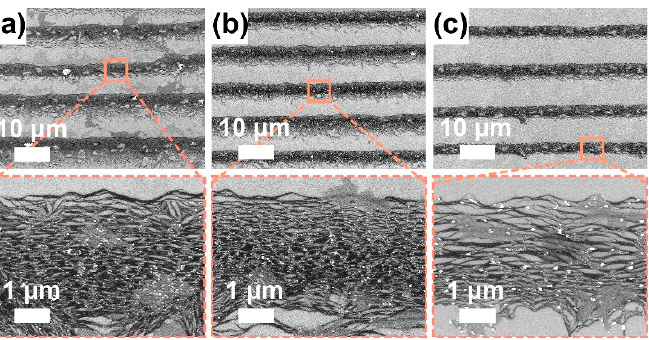
Figure 5. SEM images for P3-SWCNT films at a fixed SWCNT concentration (~70 μ g/mL), SDS con- centration (~1.0 mg/mL), environment temperature (~17 °C) and humidity (~50–70%) but varied concentration (~1.0 mg/mL), environment temperature (~17 ◦ C) and humidity (~50–70%) but varied withdrawal speed: ( a ) 0.10, ( b ) 0.15, and ( c ) 0.20 μ m/s. To characterize the alignment of SWCNTs in withdrawal speed: ( a ) 0.10, ( b ) 0.15, and ( c ) 0.20 µ m/s. To characterize the alignment of SWCNTs in stripes, high-resolution SEM images were observed. stripes, high-resolution SEM images were